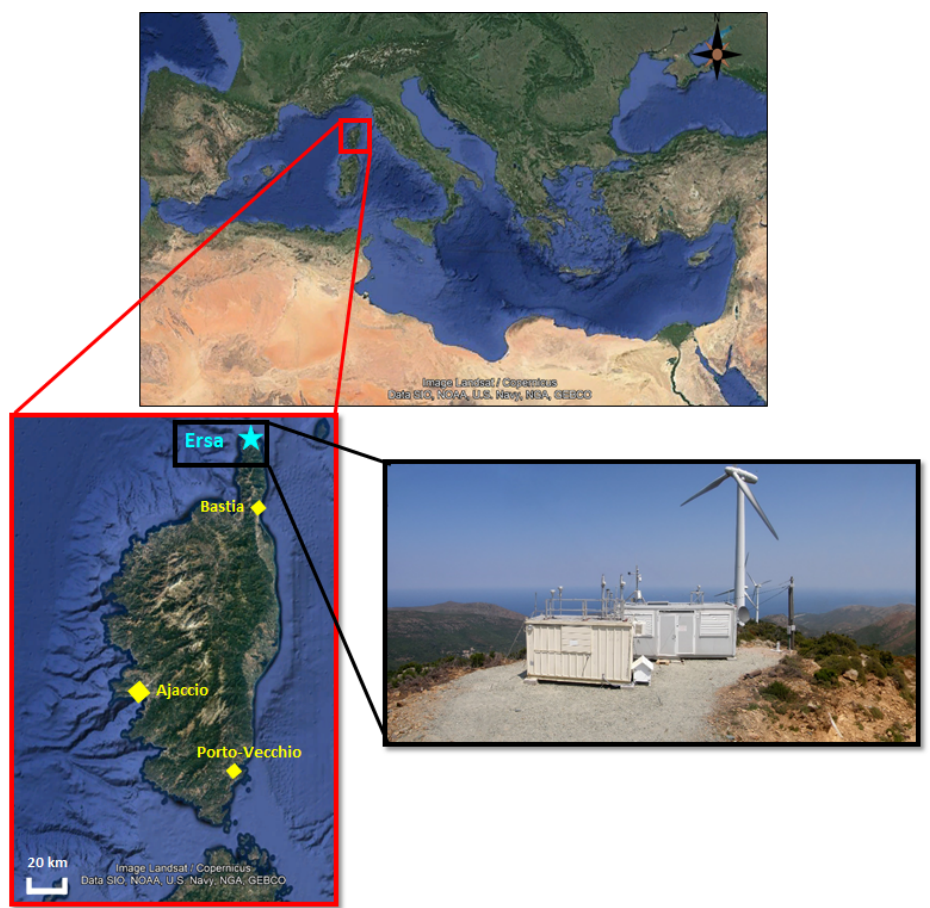
Figure 1. Maps of the Mediterranean region and Corsica (source Google Earth) and view of the sampling station. (a) Position of Corsica in the Mediterranean region. (b) The sampling site and major Corsican agglomerations are displayed as a blue star and yellow diamonds, respectively. (c) Picture of the sampling site, during the 2-year observation period. Maps provided by Google Earth Pro software (v.7.3.3; image Landsat/Copernicus; data SIO, NOAA, U.S. Navy, NGA, GEBCO; © Google